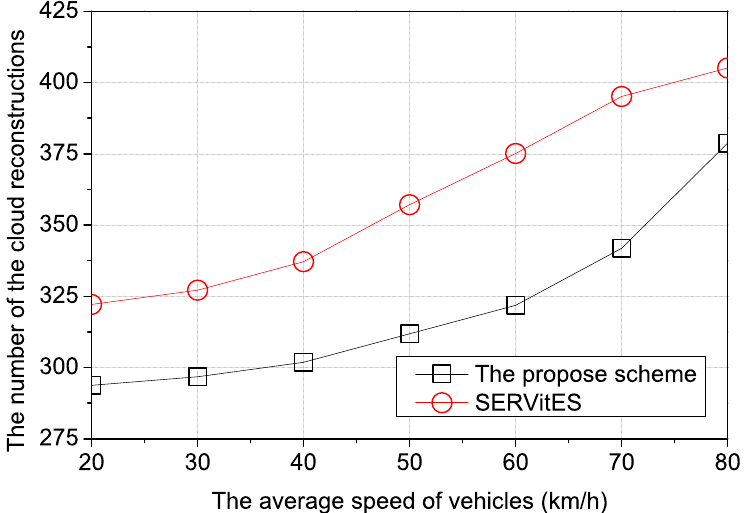
Figure 9. The number of cloud reconstructions according to the average speed of